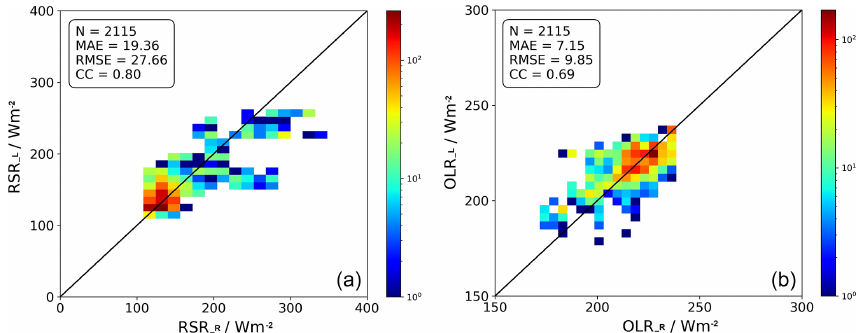
Figure 6. Comparison of TOA (a) RSR and (b) OLR from our RTM simulations (RSR _L , OLR _L ) for probed ice particles and RRUMS algorithm results (RSR _R , OLR _R ) for single SEVIRI pixel along the HALO flight on 26 March 2014. The mean absolute error (MAE), root mean square error (RMSE) and correlation coefficient (CC) are used as metrics.